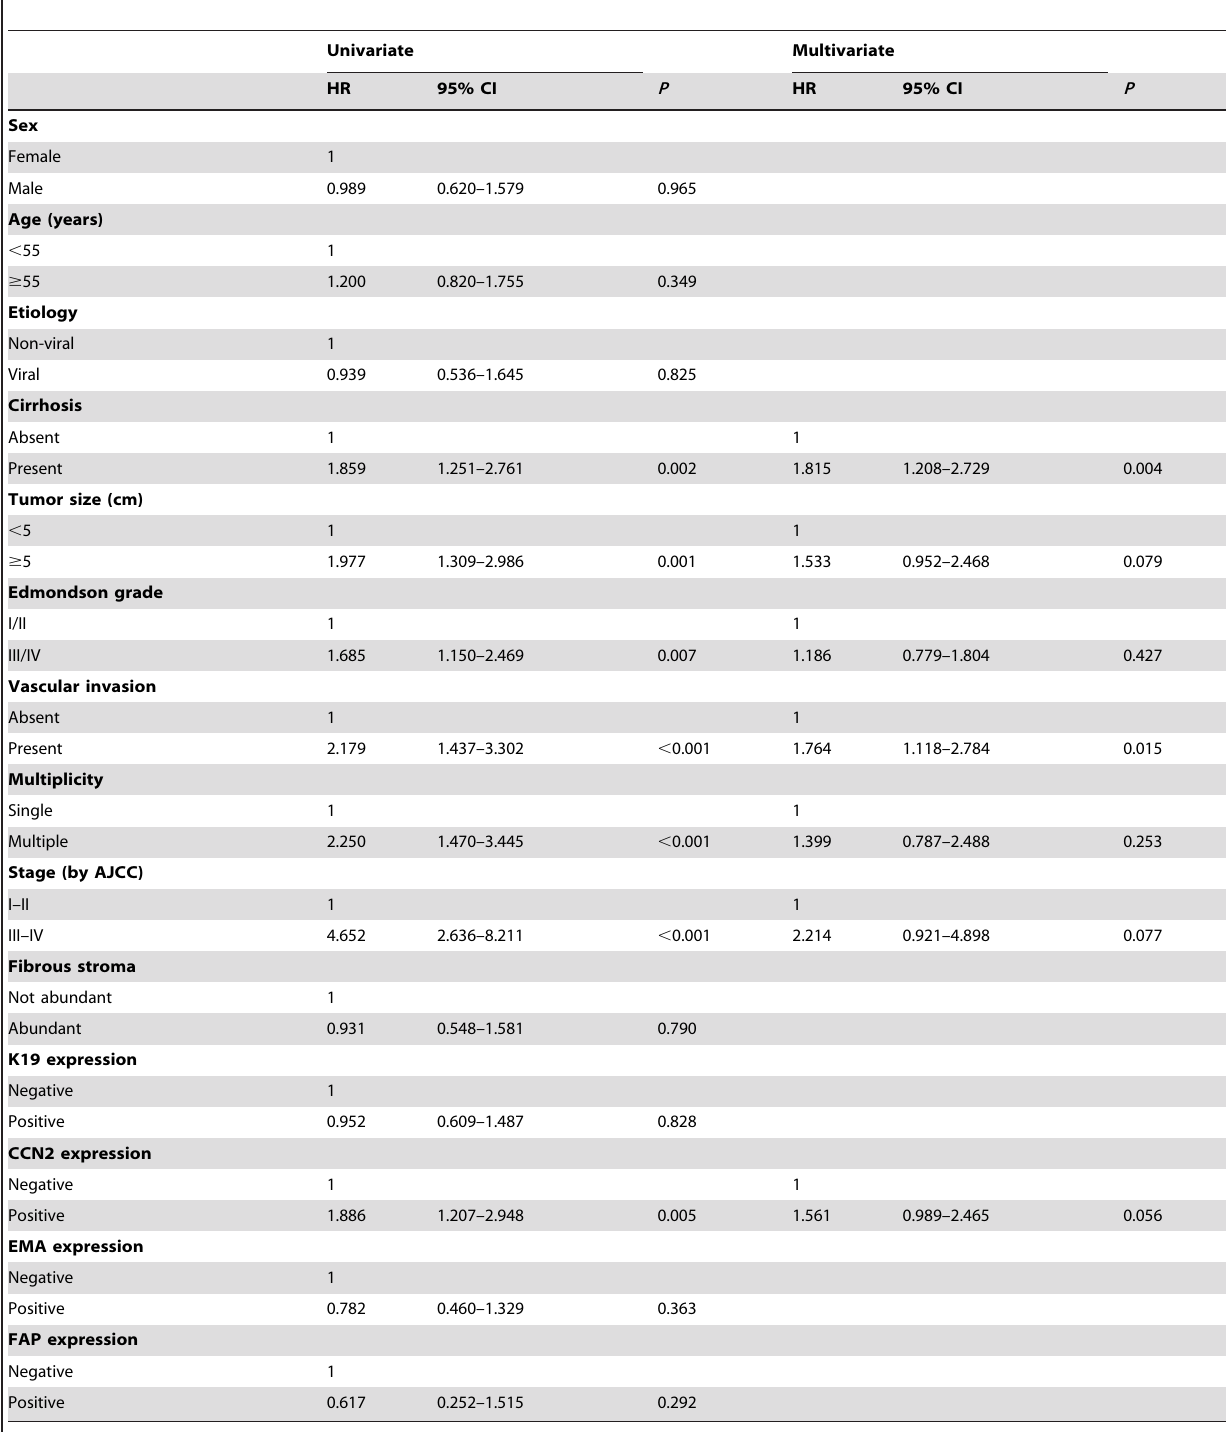
Table 3. Univariate and multivariate analysis of disease-free survival rate for HCC in cohort 1.